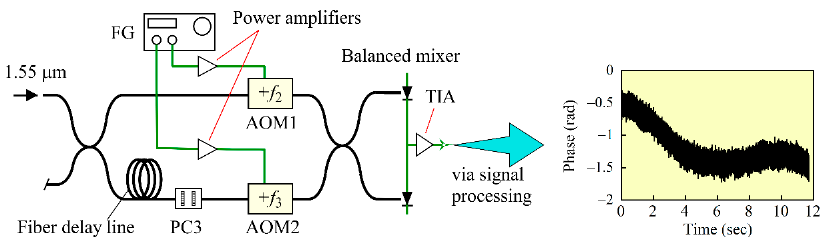
Figure 4. Schematic of an unbalanced Mach-Zehnder interferometer (MZI) used to measure frequency fluctuations of the light that was incident from the input port of the MZI. AOM1 and AOM2: Acousto-optic frequency shifters, FG: Function generator, PC3: Polarization controller, TIA: Transimpedance amplifier. f 2 and f 3 are up-conversion frequencies by the AMO1 and AOM2, respectively. PC3 was adjusted for the amplitude of the beat signal to reach its maximum value. The inset shows a typical phase change waveform, which was retrieved from the acquired beat signal waveform.